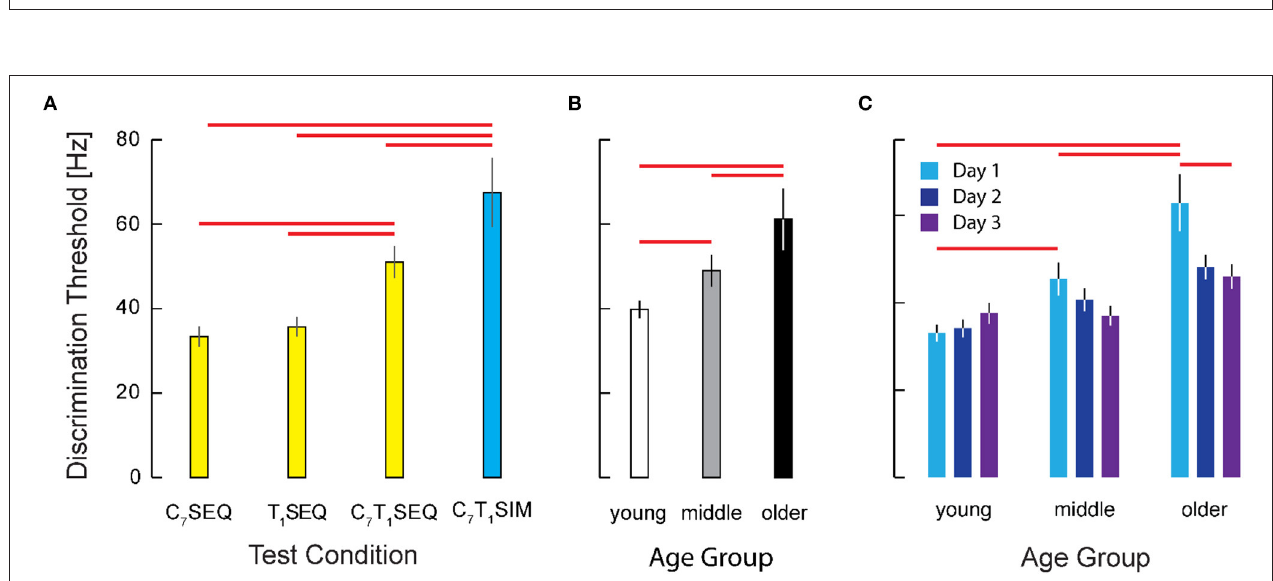
FIGURE 5 | Cohort results from experiment 2. (A) Vibrotactile discrimination threshold as a function of testing condition. Participant threshold data from the two within-dermatome conditions (C7SEQ and T1SEQ) exhibited greater discrimination acuity that the two between-dermatome conditions. Note also that the acuity of the condition with simultaneous stimulation was significantly worse than the acuities observed in all three of the sequential testing conditions. Error bars: Red horizontal significance bars: p < 0.05 after correction for multiple comparisons. (B) Main effect of age on Vibrotactile discrimination threshold. (C) Interaction between age group and testing day. Note the significant training effect across days in the older age group (but not the younger or middle-age groups).